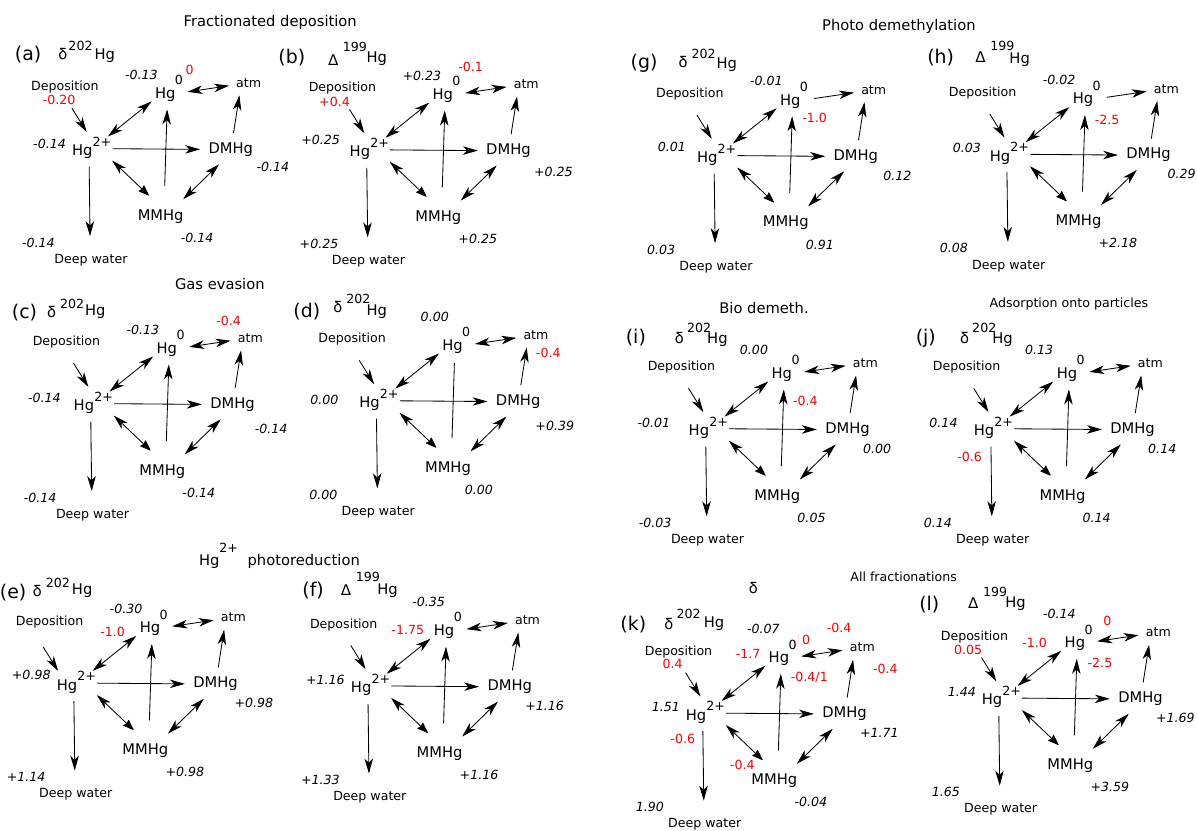
Figure 11. Schematic of the expression of isotopic fractionations on the global mean sea surface isotopic signatures of the Hg species in the model, for preanthropogenic steady state. Fractionation epsilon values are shown in red, expressed as per mill differences in the 202 Hg / 198 Hg ratio. Resulting global surface average δ 202 Hg values for each species are in black italics. Isotopic compositions of the wet and dry deposition are preanthropogenic estimates from Sun et al. (2016 #9). (a) The signature of mass-dependent fractionation in Hg 2 = deposition. (b) Mass independent (cid:49) 199 Hg signature of wet deposition. (c) Fractionation associated with Hg(0) evasion (Wiederhold et al., 2010). (d) Fractionation applied to DMHg evasion (assuming the same fractionation as for Hg(0) evasion). (e, f) Fractionation is applied in the reduction of Hg(II) to form Hg(0) (Kritee et al., 2007). (g, f) Fractionation in biological and photodemethylation or photoreduction of MMHg to form Hg(0). The ε 202 isotopic fractionation is taken to be a weighted average of biological (Kritee et al., 2007) and photochemical fractionation (Bergquist and Blum, 2007; Blum et al., 2014), while the ε 199 is from Bergquist and Blum (2007). (g) Fractionation of biological MMHg production from Rodriguez-Gonzalez et al. (2009). (h) Biological demethylation from Kritee et al. (2007). (i) Fractionation during adsorption of Hg(II) onto POC is from Wiederhold et al.